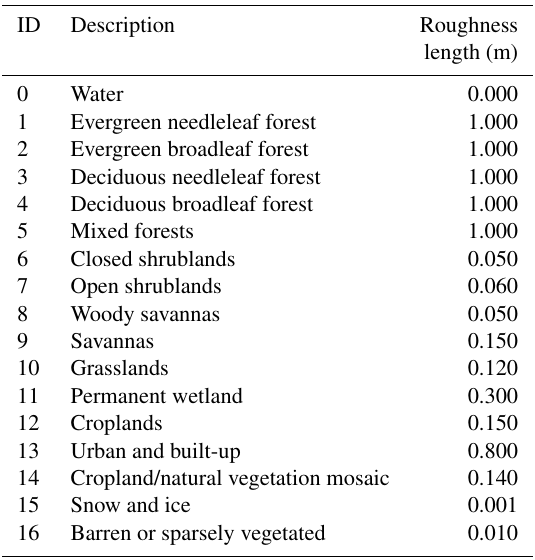
Table A2. Land cover table used for the MODIS-based maps (Thøgersen,